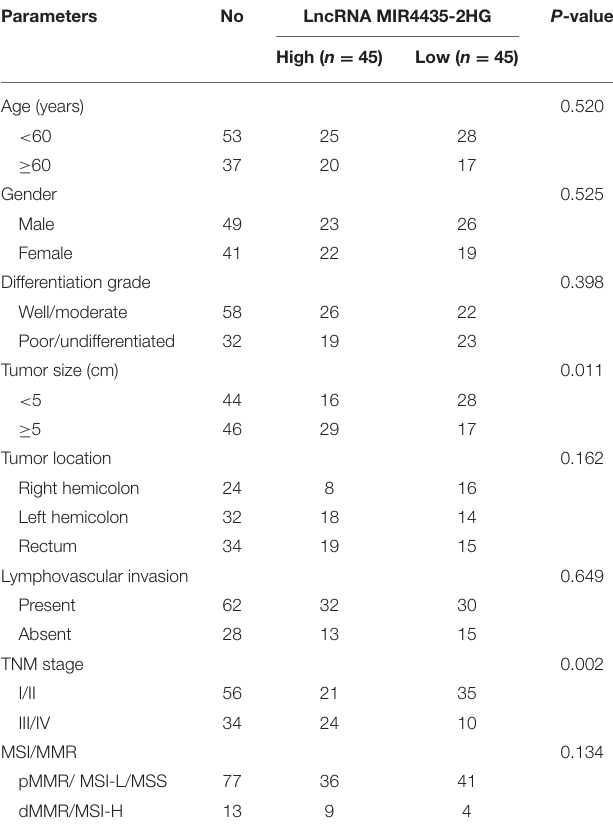
TABLE 1 | Correlations between lncRNA MIR4435-2HG expression and clinicopathological characteristics in CRC.